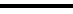
Figure 13. Glass bracelet of Middle Byzantine period from the excavation in 2015 (archive of the Ephorate of Antiquities at Kilkis, photo Stamatis